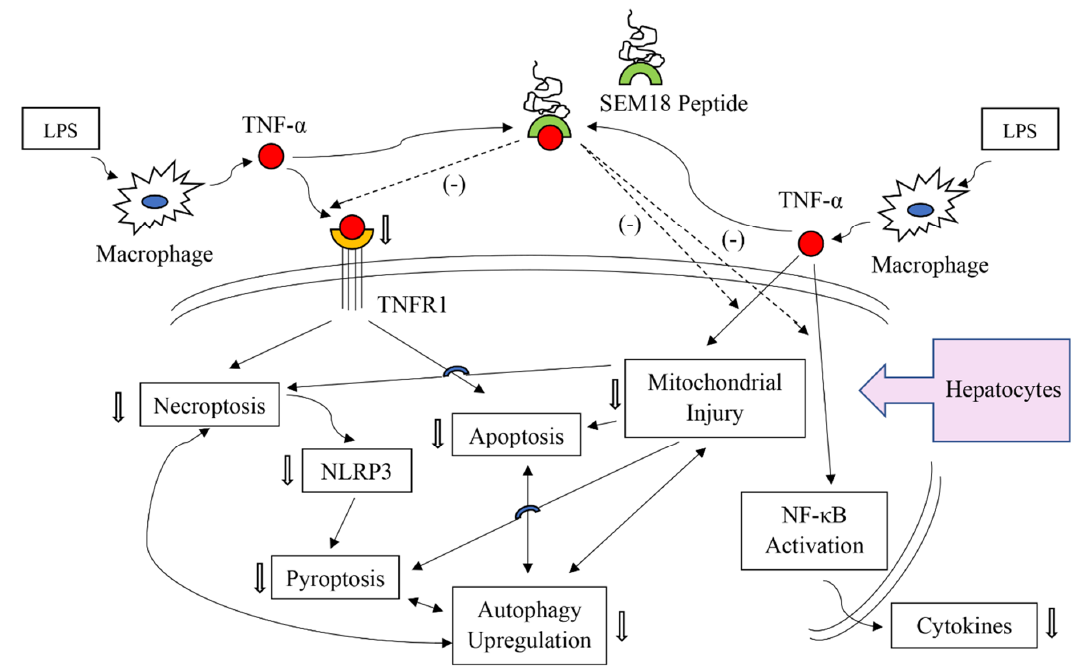
Figure 8. Illustration of the proposed possible mechanisms of SEM18 peptide on inhibiting endotoxin- induced liver injury in hepatocytes. LPS: lipopolysaccharide; TNF-α: tumor necrosis factor-α; TNFR1: tumor necrosis factor receptor 1; NF-κB: nuclear factor-κB. indicating confirmed inhibition effects of SEM18 peptide; ⇢ indicating presumed effects of SEM18 peptide.